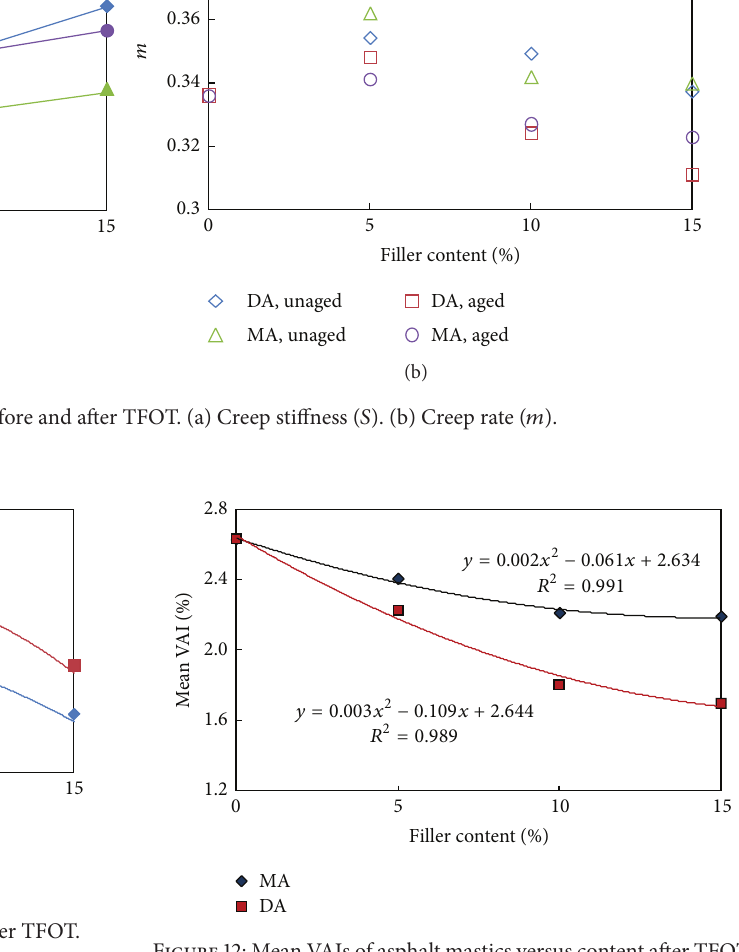
Figure 12: Mean VAIs of asphalt mastics versus content after